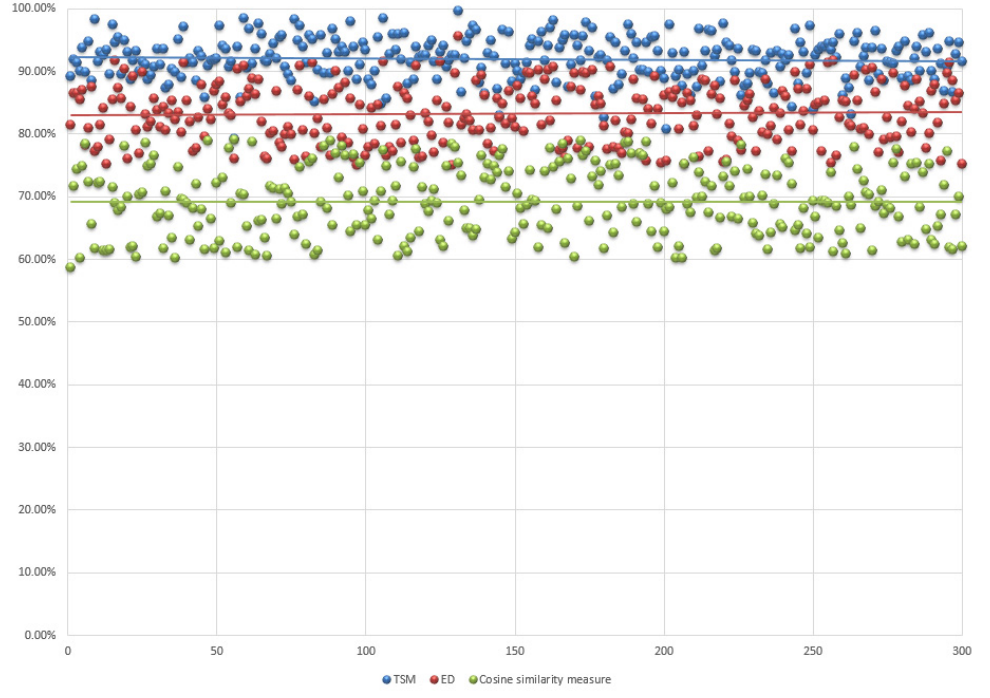
Figure 9. The result of all 300 retrieval tasks by TSM, ED, and cosine similarity measure. Table 4. Comparative result of three similarity measures in selected cases.